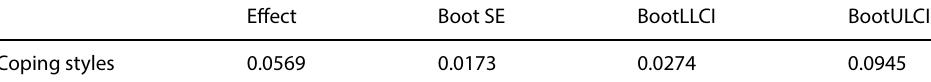
Table 2 Table of intermediate effect test